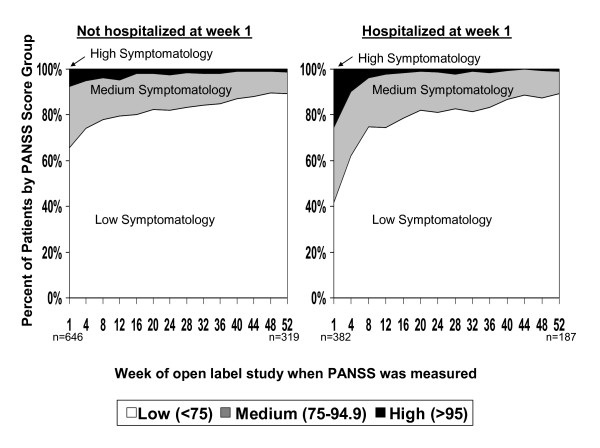
Percentage of patients by Positive And Negative Syndrome Scale (PANSS) score category by week of PANSS administration and hospitalization status at week 1 (the start of the open-label phase).